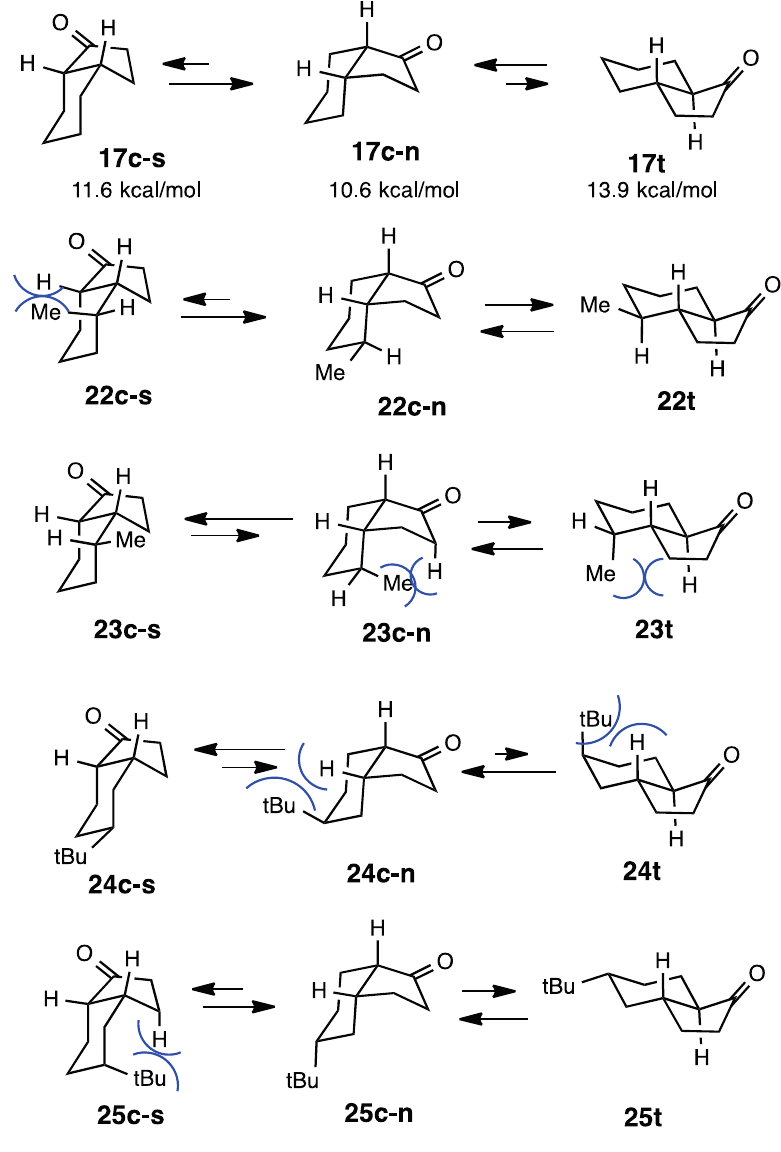
Scheme 7. Conformations of compounds 22 - 25